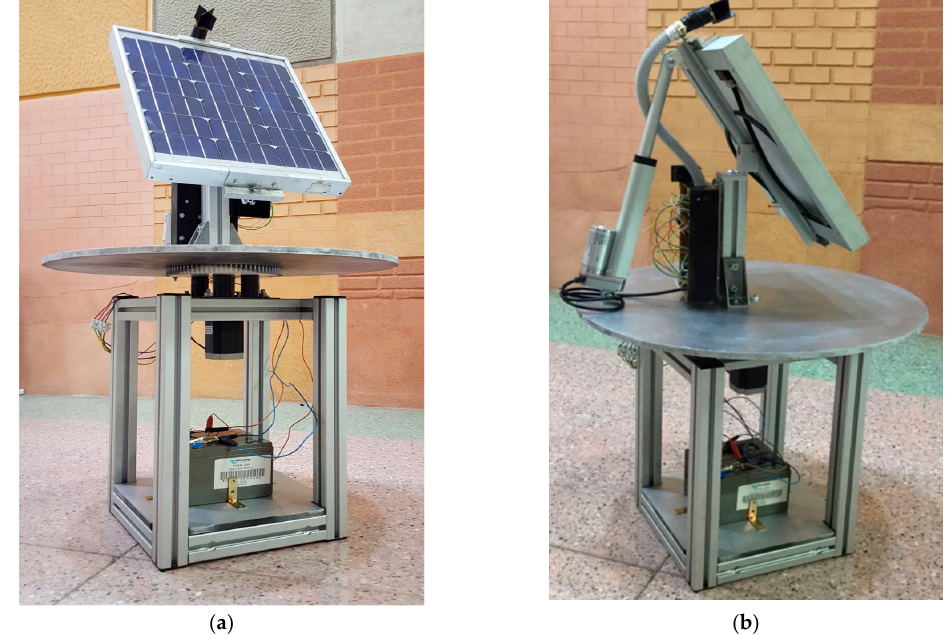
Figure 9. Designed photovoltaic solar tracker: ( a ) Front view; and ( b ) Side view.